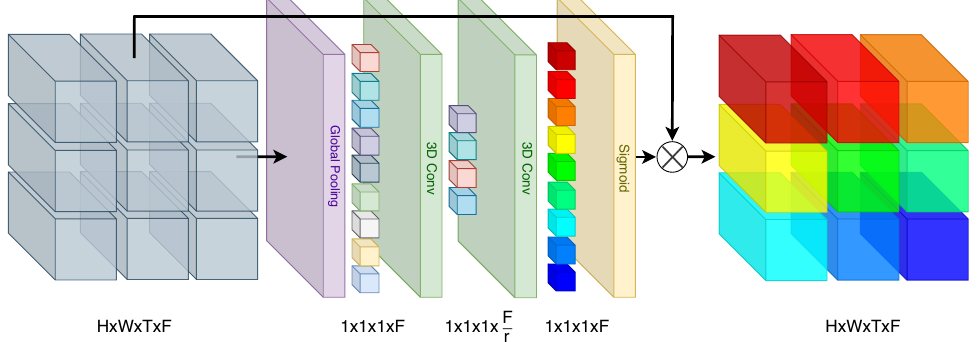
Figure 2. Reference architecture of a feature attention block. A series of convolutional operations and non-linear activations are applied to the input tensor with shape H × W × T × F in order to generate different attention statistics for each feature F that concurrently take advantage of local and non-local correlations. Consequently, each tensor’s feature is properly re-scaled, enabling the network to focus on most promising components and letting residual connections heed of all redundant low-frequency